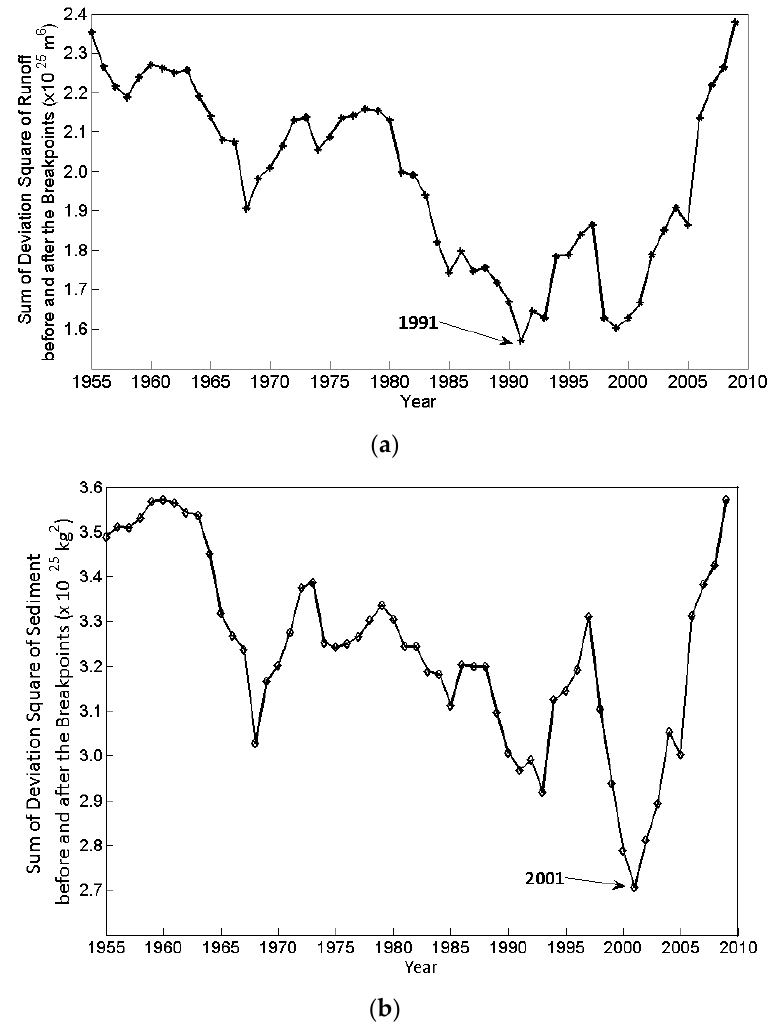
Figure 5. Fisher’s ordered clustering curves of runoff and sediment into the TGP: ( a ) Runoff; ( b ) Sediment. Table 1. Annual average value of runoff and sediment inflow of reservoir TGP before and after abrupt.